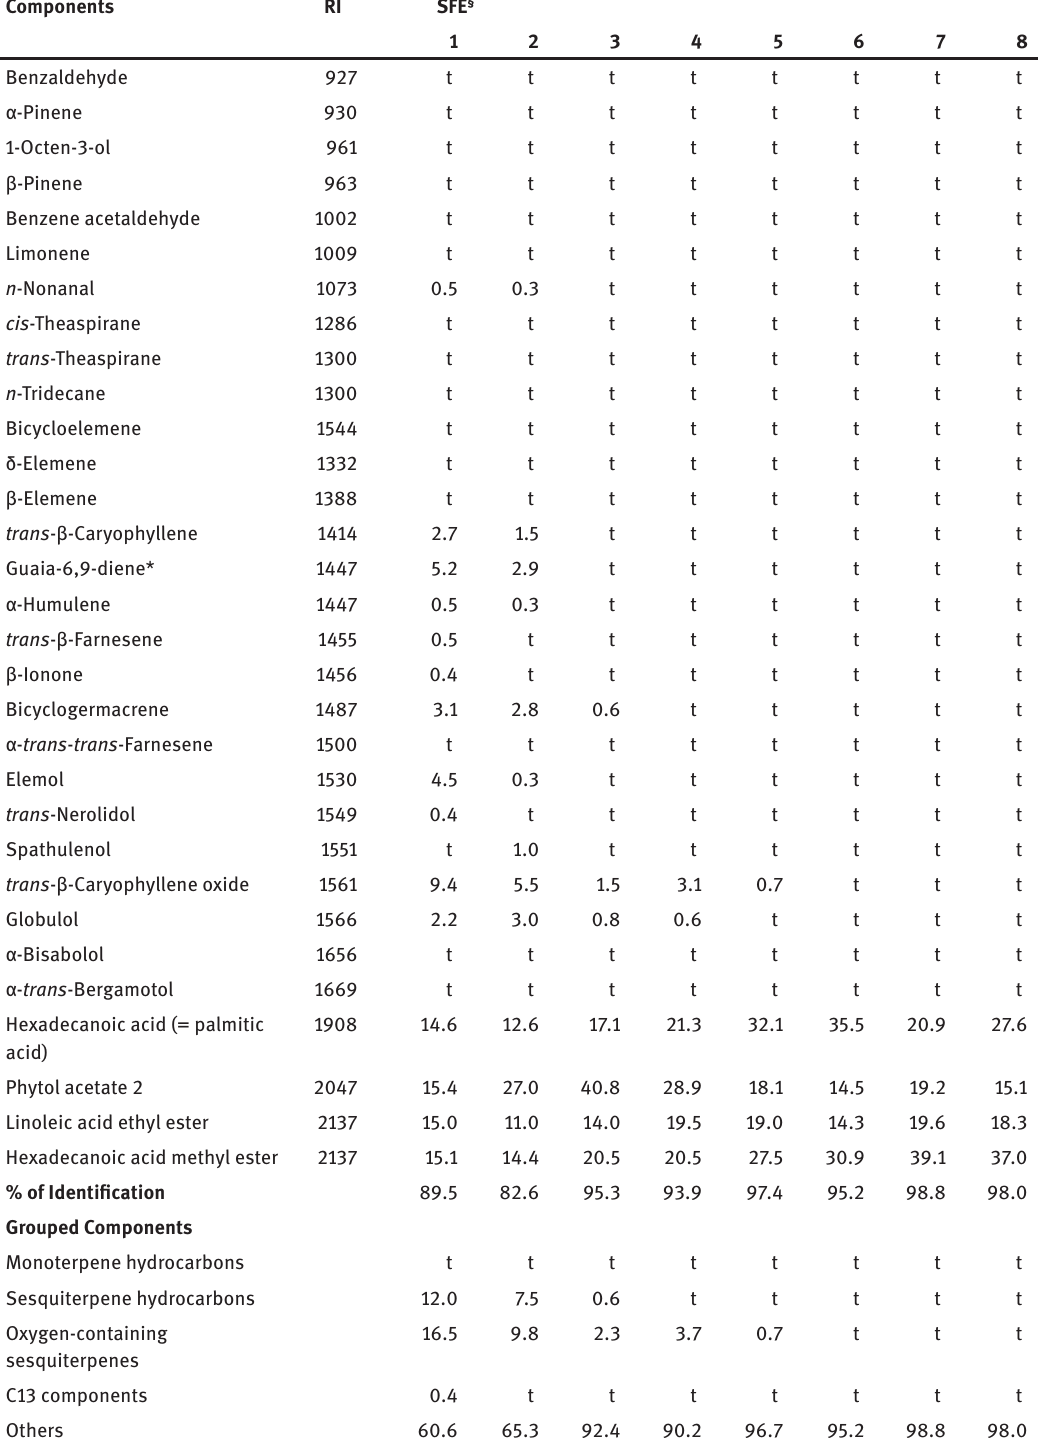
Table 1 : Composition of the volatiles extracted by supercritical fluid extraction (SFE) from the dried flowering aerial parts of Salvia sclareoides